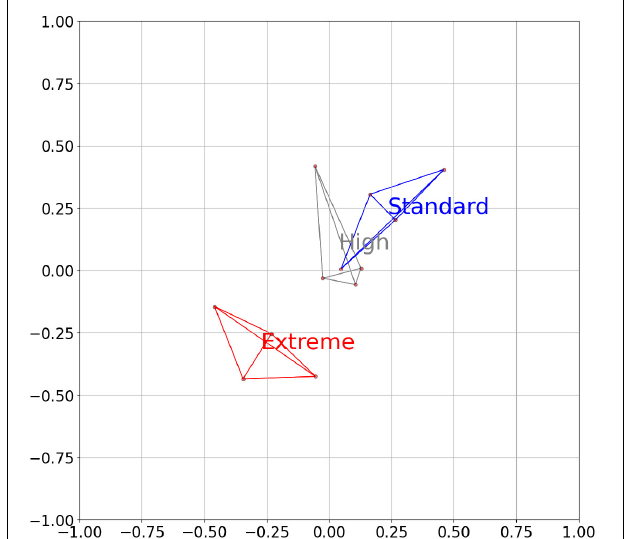
FIGURE 1 | An MDS plot of the individual cows based in the abundance of the bins from the rumen. The clustering of results from the four cows of each feeding regime is indicated by color (blue, Standard; yellow, High; and red, Extreme). The axes are arbitrary values resulting from the reduction of the multidimensional space of correlation similarities into two